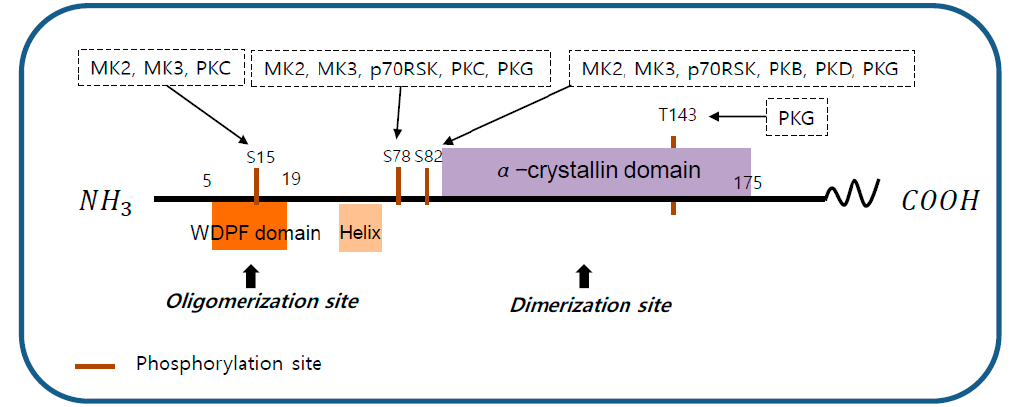
Figure 2. The structure of heat shock protein 27 (HSP27). The structure of human HSP27 consists of the N-terminal domain, the α -crystallin domain, and the C-terminal domain. The N-terminal domain contains a WDPF motif which is essential for large oligomerization. The C-terminal domain includes an α -crystallin motif that is highly conserved between species and is involved in the formation of small oligomerization. HSP27 phosphorylation sites S15, S78, S82, and T143 are indicated. S15 can be phosphorylated by p38 mitogen-activated protein kinase (MAPK)-activated protein kinase 2 (MK2) and 3 (MK3), and protein kinase C (PKC). S78 can be phosphorylated by MK2, MK3, ribosomal S6 kinase (p70RSK), PKC, and protein kinase G (PKG). S82 can be phosphorylated by MK2, MK3, p70RSK, protein kinase B (PKB), protein kinase D (PKD), and PKG. T143 can be phosphorylated by PKG.